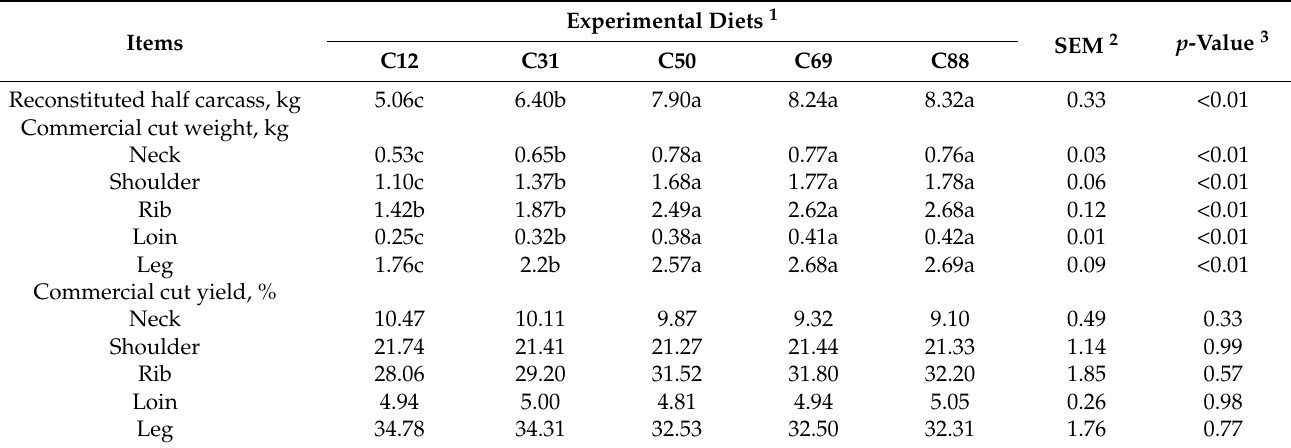
Table 5. Effect of dietary forage-to-concentrate ratios on weight and yield of commercial cuts from ambs.